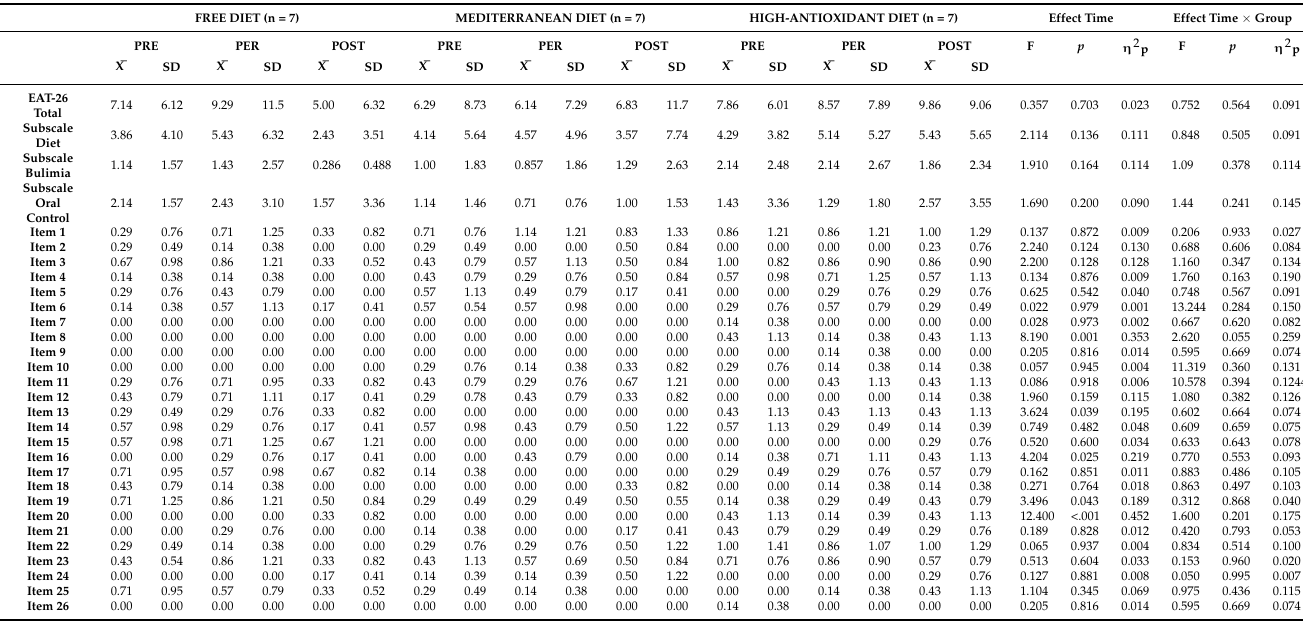
Table 2. Eating Attitude Test variables before, during and after the intervention in the free diet, Mediterranean diet and antioxidant-rich diet groups. FREE DIET (n = 7)